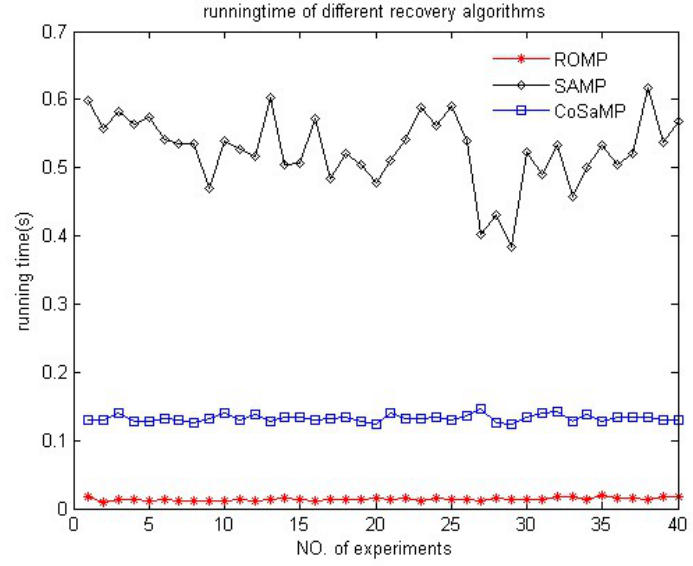
Figure 15. Comparison of running time among three recovery